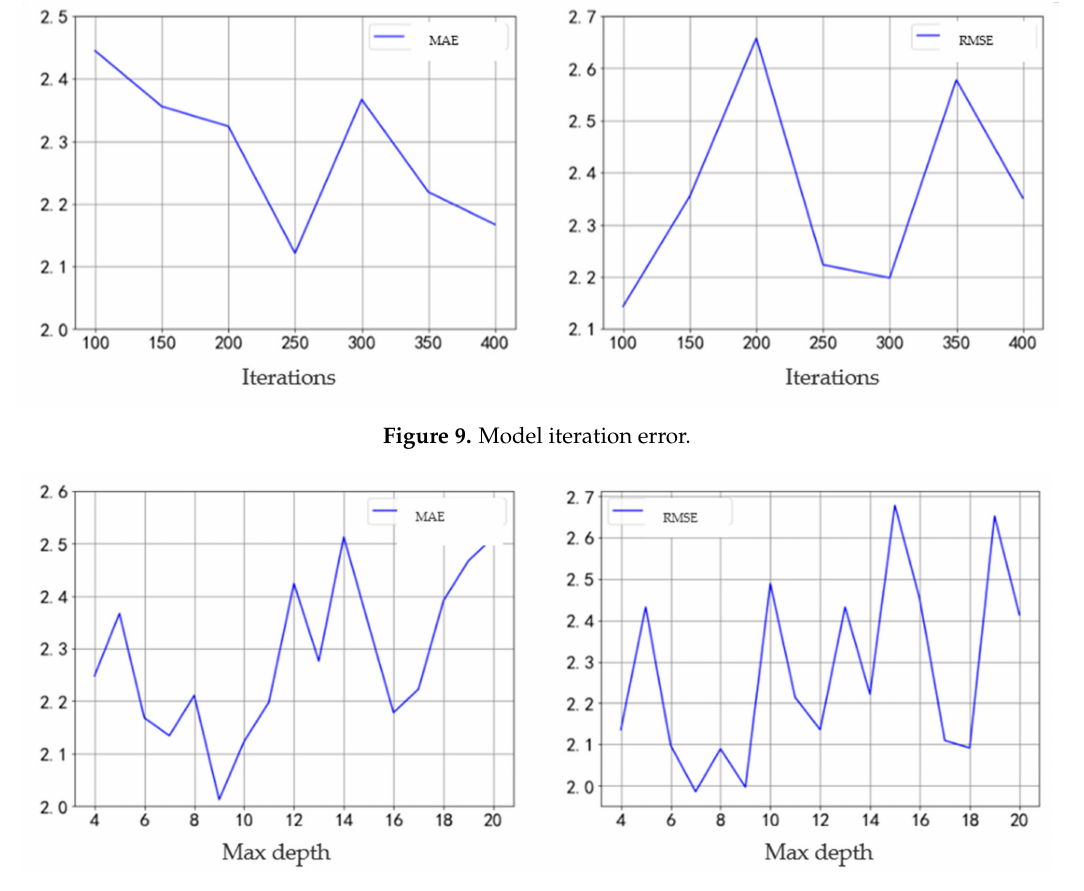
Figure 10. Max depth error. Table 6. Optimal parameter list.